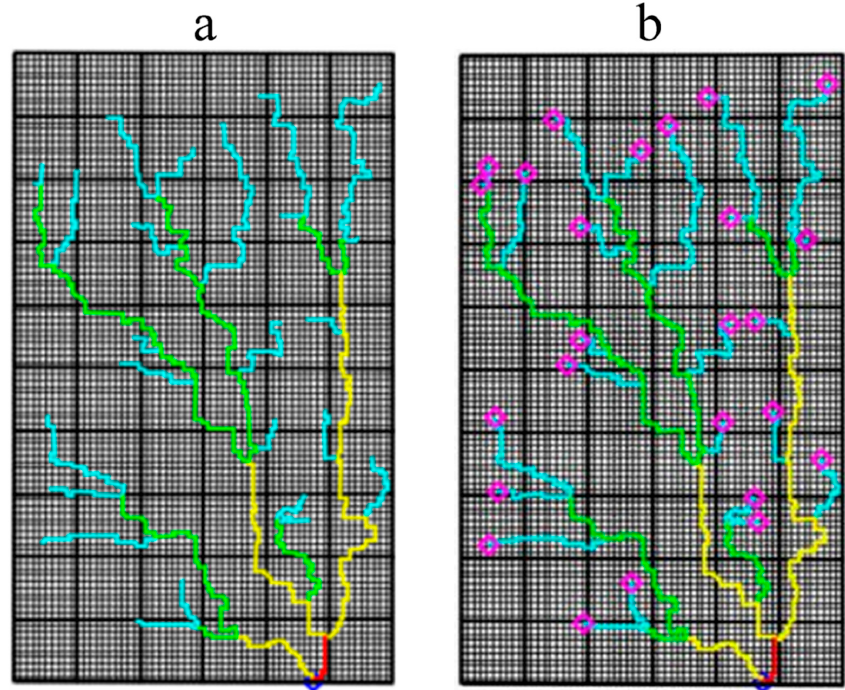
conduits, respectively. Rectilinear branchwork and network maze patterns with different conduit